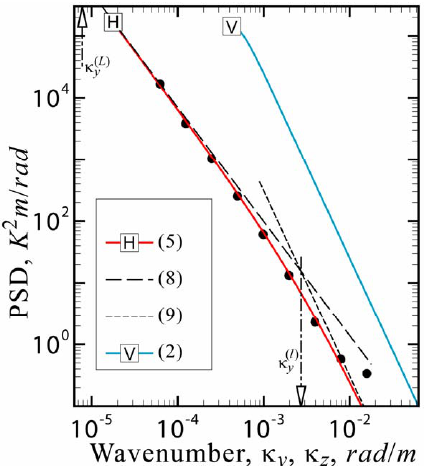
Fig. 2. Comparison of the modeled horizontal (H) and vertical (V) spectra with the measurements (Bacmeister et al., 1996). The dots depict the measurements. The equations used to calculate spectral densities (solid curved lines) and the asymptotic power-law functions (dashed straight lines), are referred to in the legend. Vertical arrows indicate the characteristic wavenumbers.